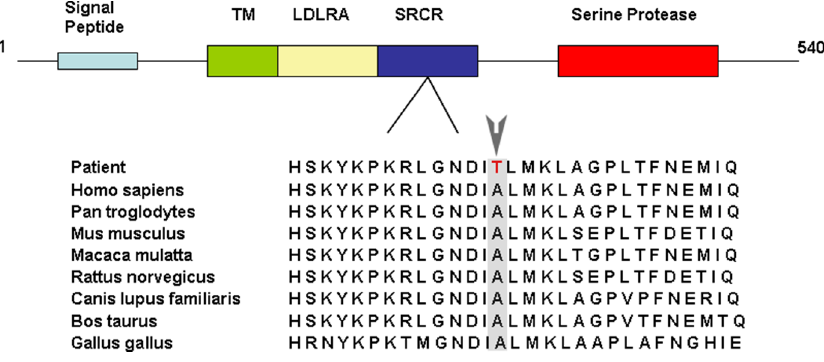
Figure 4. Human TMPRSS3 protein domains and the analysis of evolutionary conservation for the sequence around the mutation site. The TMPRSS3 protein consists of 540 amino acids and contains a signal peptide, a transmembrane (TM) domain, a low density lipoprotein receptor A (LDLRA) domain, a scavenger receptor cysteine rich (SRCR) domain, and a carboxyl terminal serine protease domain. The Alanine (179) in the SRCR domain, which is mutated to Threonine in the two patients, is highly conserved in